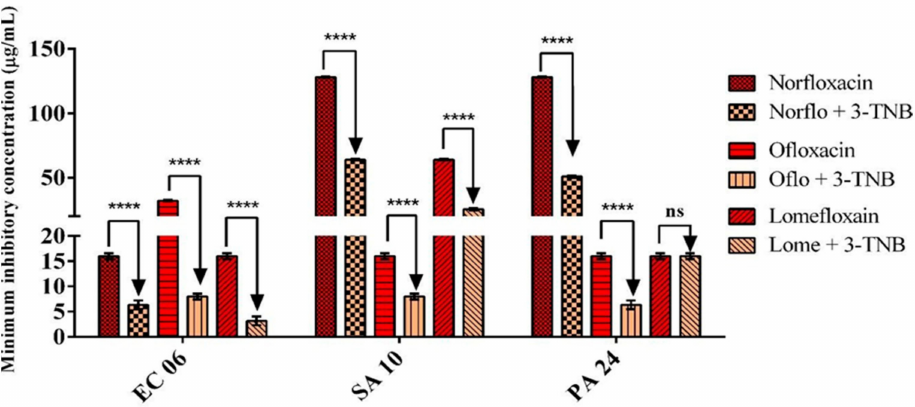
Figure 2. Antibiotic-modulating activity of 3-trifluoromethyl- N -(5-chloro-1,8-naphthyridin-2-yl)- benzenesulfonamide (3-TNB) in combination with norfloxacin, ofloxacin, and lomefloxacin against E. coli 06, S. aureus 10, and P. aeruginosa 24. **** Statistical significance: p < 0.0001; ns: not